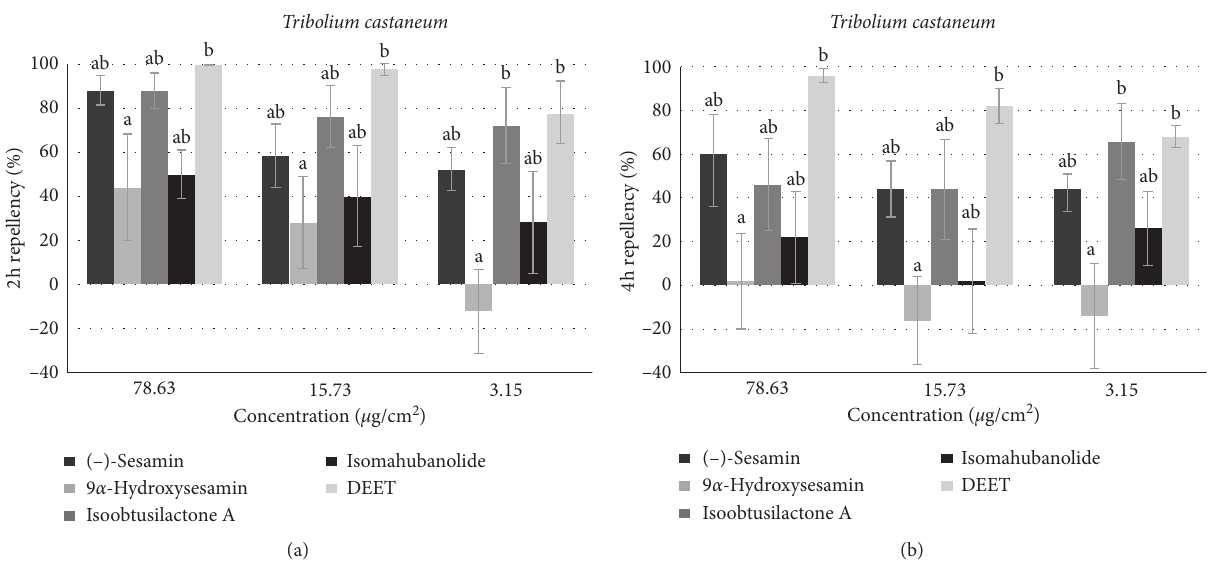
Figure 3: Percentage repellency (PR) of two lignans and two butanolides isolated from the C. camphora stem bark against T. castaneum at 2h (a) and 4h (b) after exposure. Means in the same column followed by the same letters do not differ significantly ( P > 0 . 05) in ANOVA analysis (Tukey’s HSD test). Table 1: Feeding deterrent activities of four compounds isolated from the stem barks of C. camphora against T. castaneum .